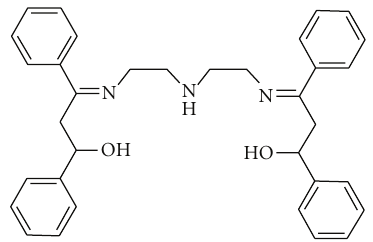
Scheme 1: Schematic representation of ligand [3- { 2-[2-(3- hydroxy-1,3-diphenyl-allylideneamino)-ethylamino]-ethylimino } - 1,3-diphenyl-propen-1-ol] (L).